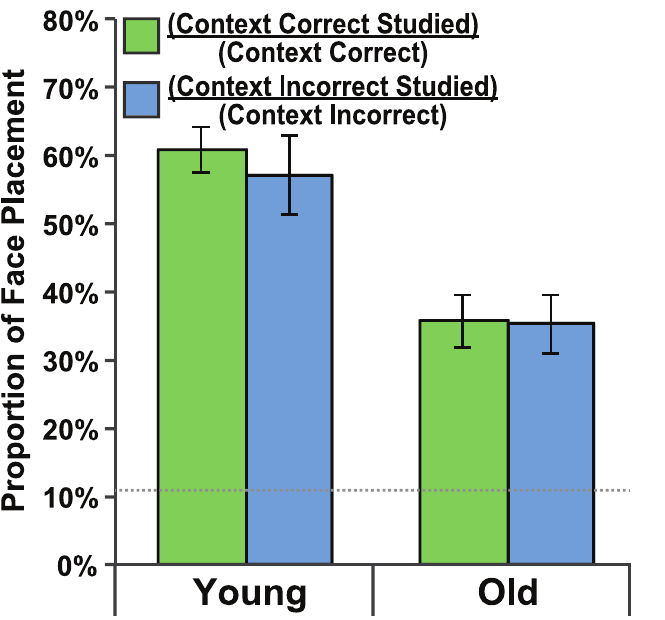
Fig 6. Studied room preference. Preference for face placements to the studied room as a proportion of all face placements to a given side of the building. Green bars indicate a preference for the studied room on the context-correct side of the building. Blue bars indicate a preference for the studied room on the context- incorrect side of the building. Data are presented for both the Young Adult and Older Adult groups and standard error bars are shown. The dotted gray line indicates chance-level